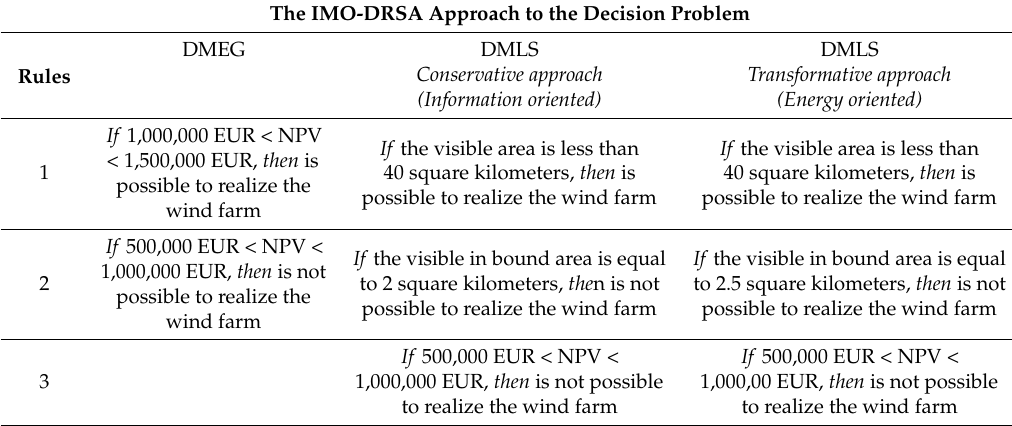
Table 5. Decision-making rules for the three approaches.